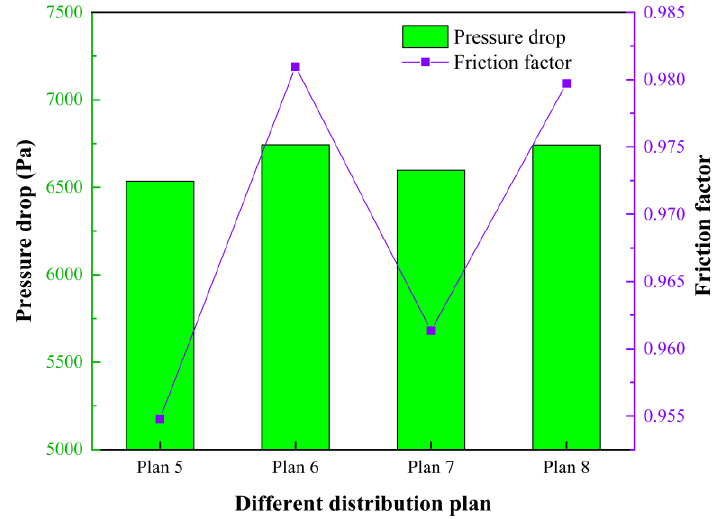
Figure 13. Channel performance under different distribution plans.